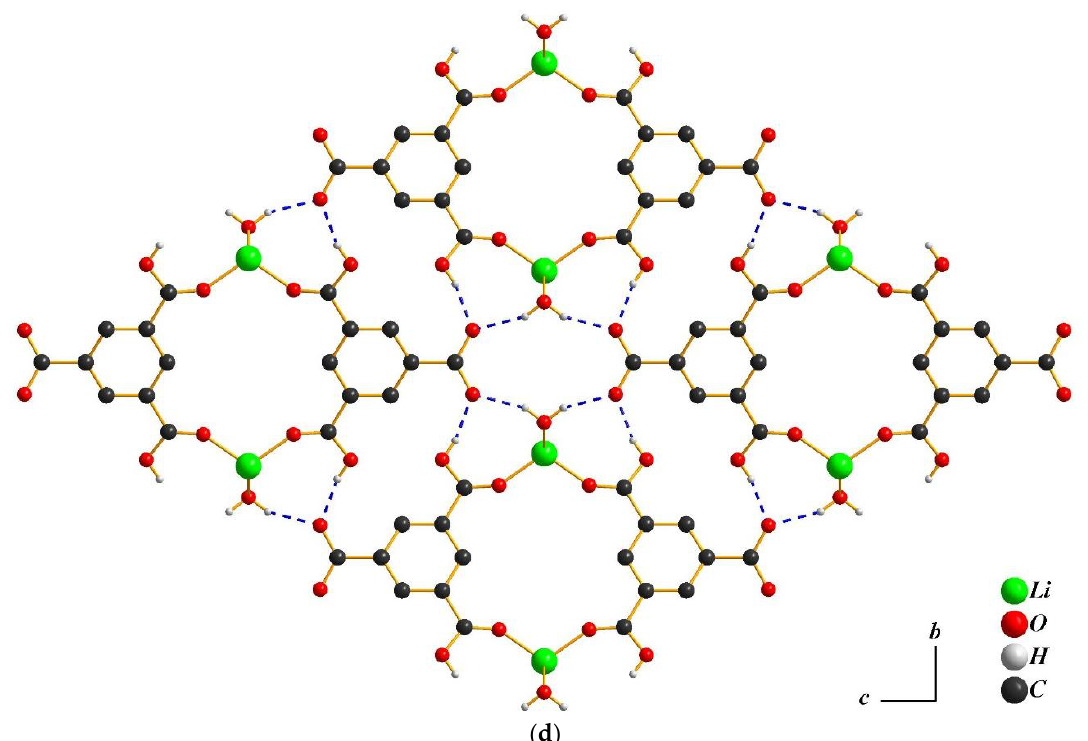
Figure 4. ( a ) The coordination spheres of lithium atoms in 4 ; ( b ) the coordination model of the BTC ligand in 4 ; ( c ) the 1-D chain of 4 . ( d ) The 1-D chains viewed along the a -axis of 4 .